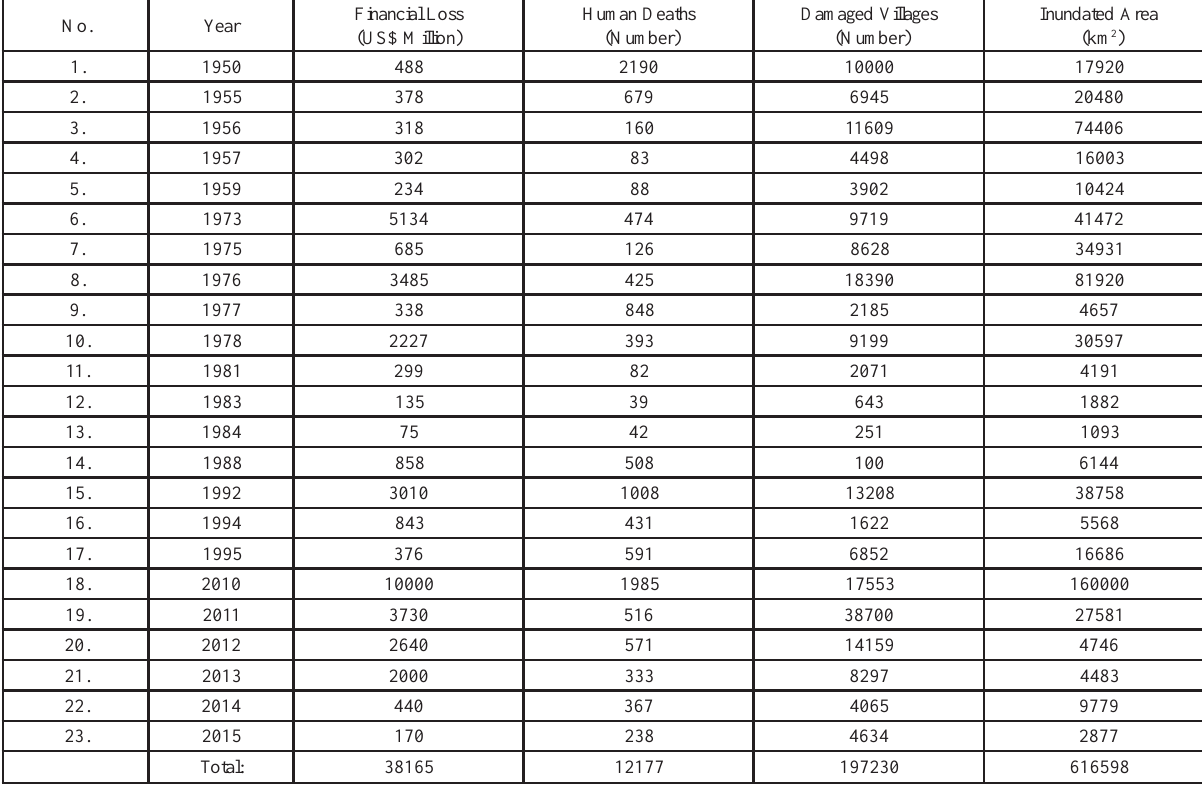
TABLE 1. HISTORICAL FLOODS AND DAMAGES